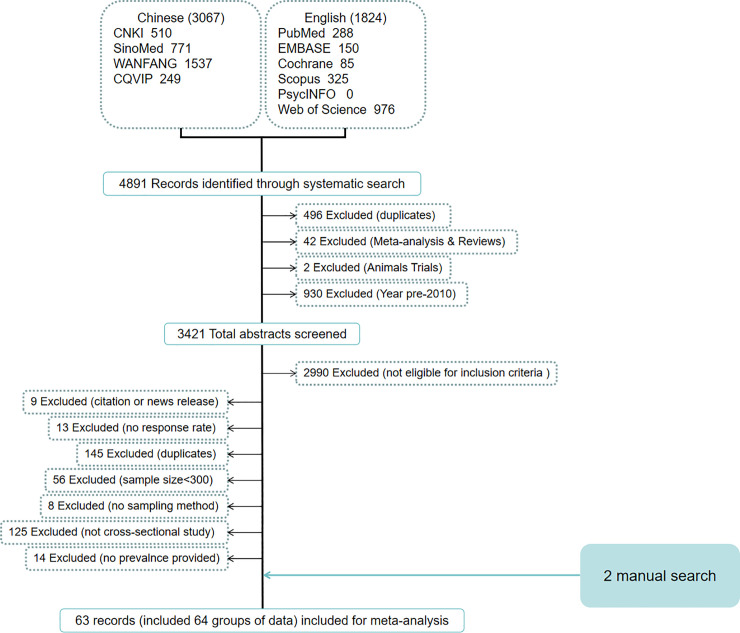
Screening process.